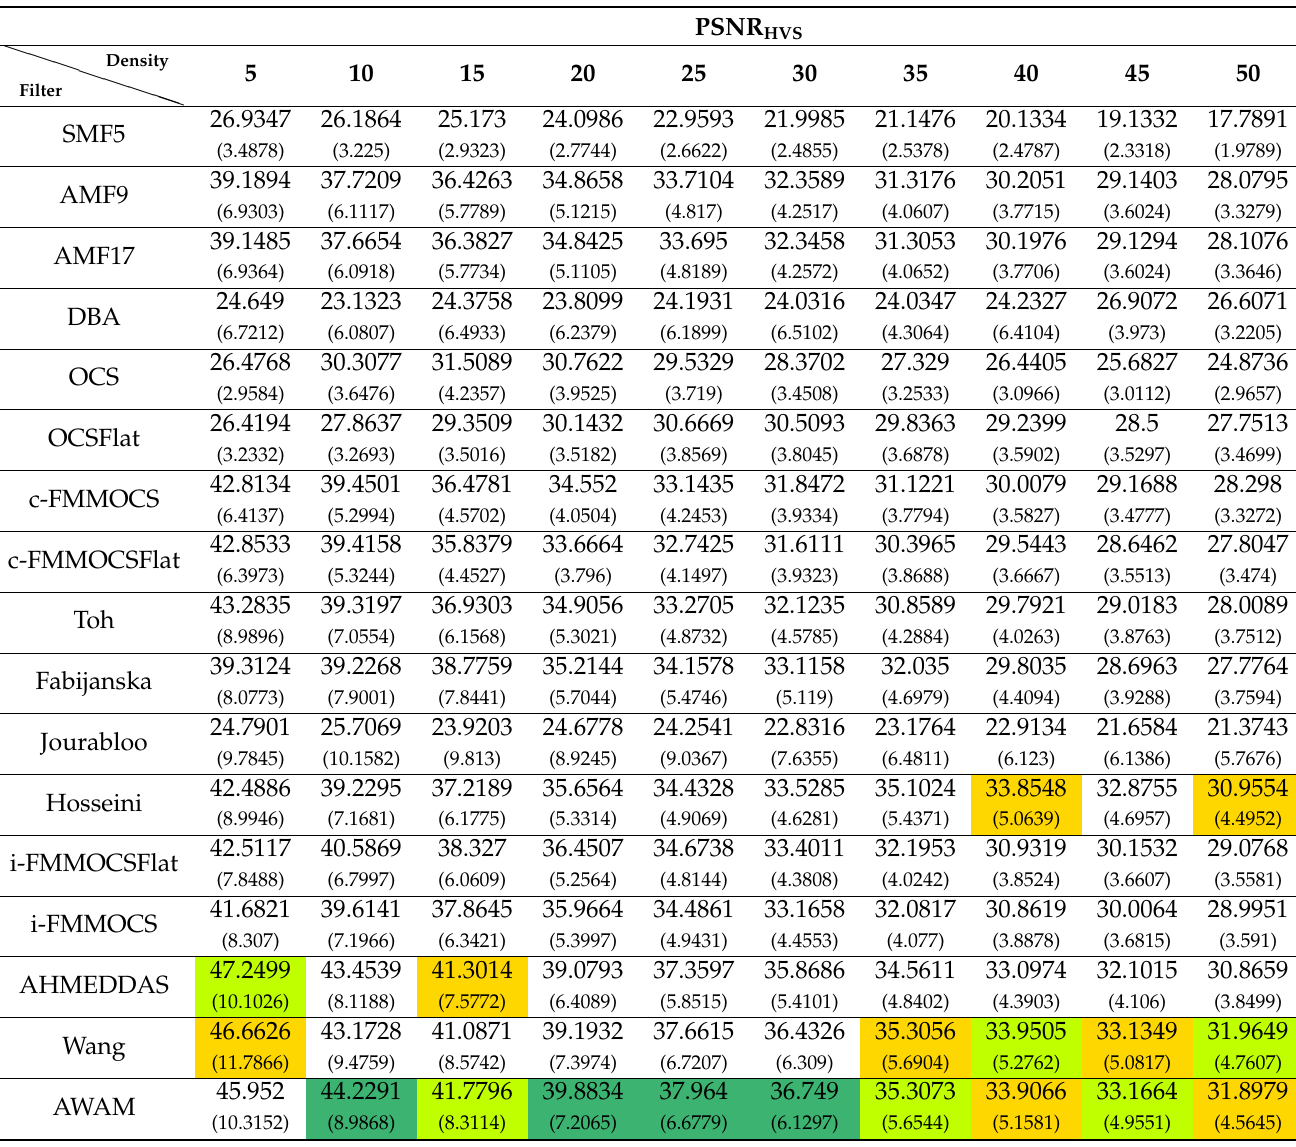
Tables 3 and 4 show the means and standard deviations using the performance measure PSNR HVS of the filters considered for all noise densities. The meaning of the color of the cells is similar to the meaning of the color of the cells of Table 2. The AWAM filter corresponds to the last row and 9 of the 20 possibles boxes, are coloured green and 10 in lime. It means that the AWAM filter almost always outperforms all others filters and in all other filters and in 10, it outperforms them but not significantly. Table 3. PSNR HVS average values and standard deviations of the studied algorithms for the sequence of densities of noise from 5% to 50% with a step of 5%. For a concrete density, green cells mean that the filter gets the highest average value, significantly surpassing the competitors; lime cells mean that the filter achieves the highest average value but its results are not statistically different from the ones obtained by the filters depicted in